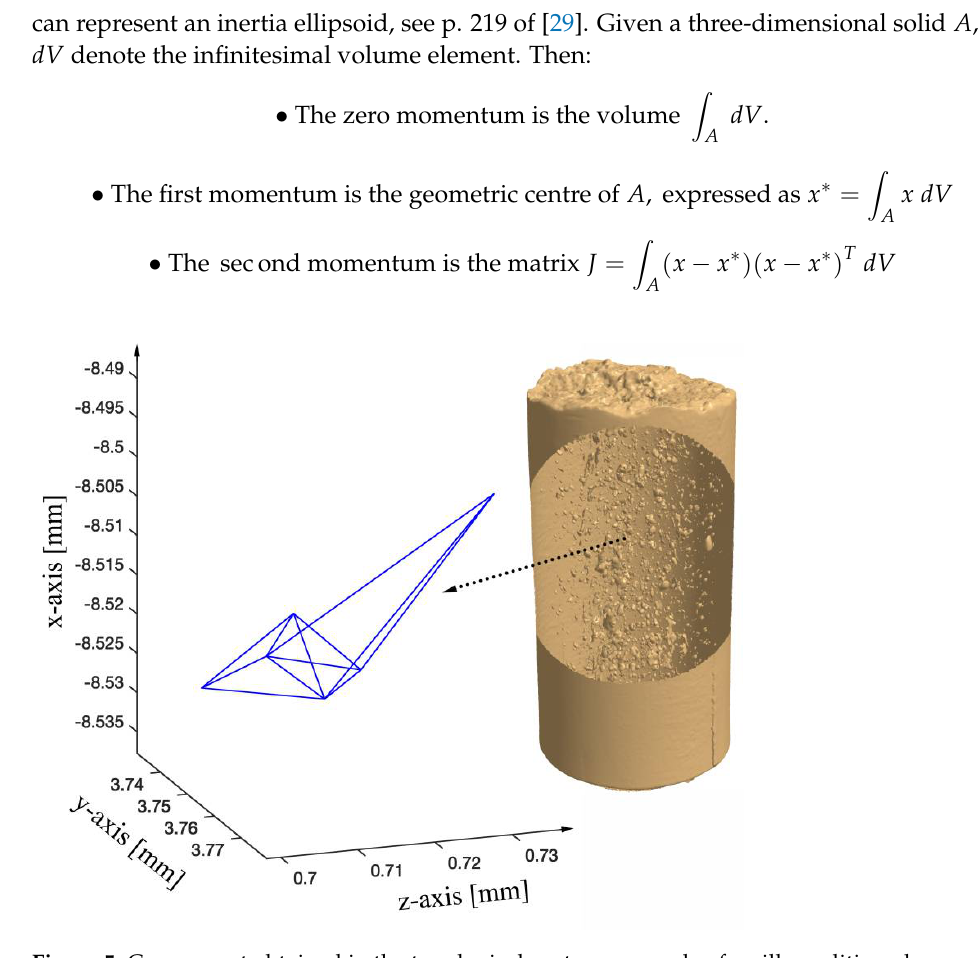
Figure 5. Component obtained in the topological part: an example of an ill-conditioned geometry due to the intersection of triangles, which should represent an outer boundary of the pore.